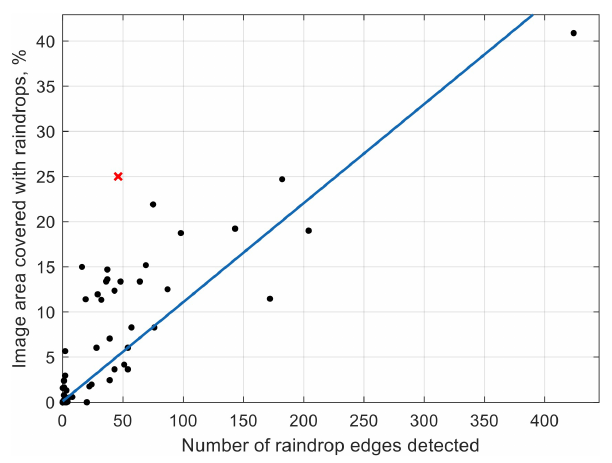
Figure 3. Correlation between the number of raindrop edges de- tected by the algorithm and the total area covered by